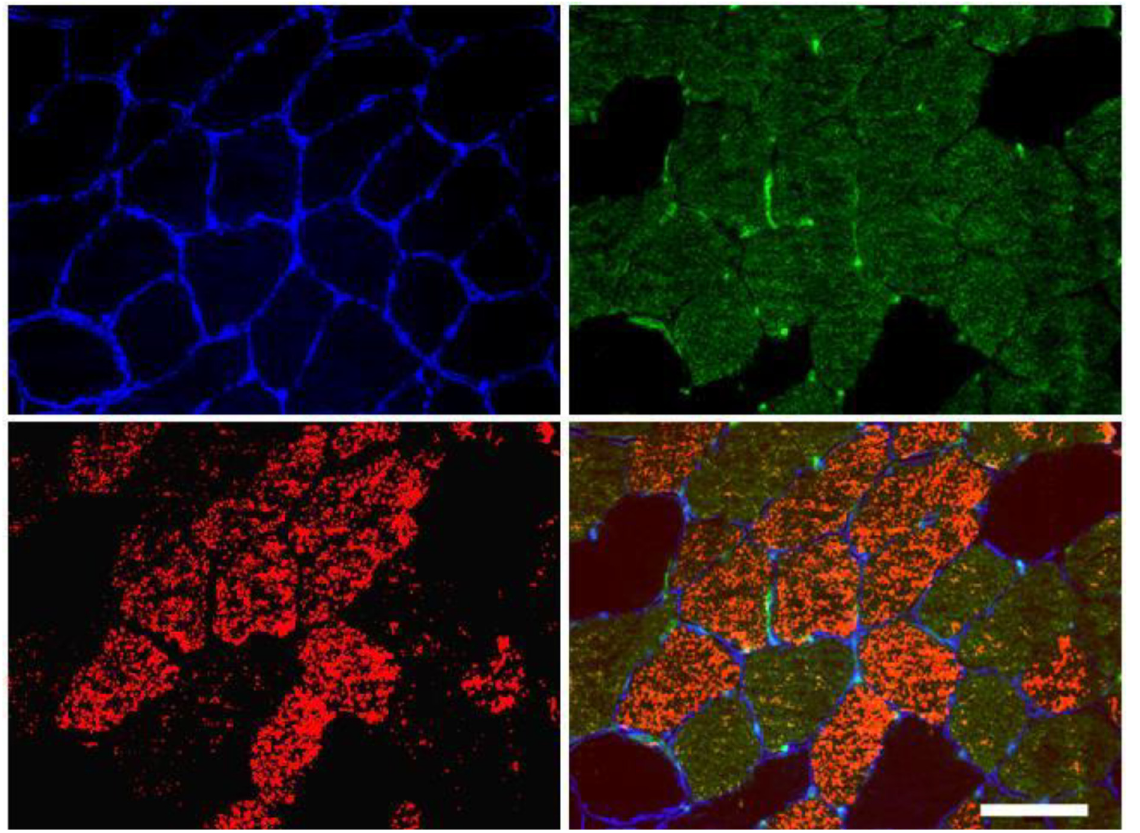
Fig 2. Representative immunofluorescent histochemical staining. Targets shown are; myofibre borders (top left/blue), capillaries (top right/light green) and myofibre type I/IIA (top right/dark green), myofibre type slow/type I (bottom left/red) and a merged over-lay af the above (bottom right). Scale bar = 100 μ